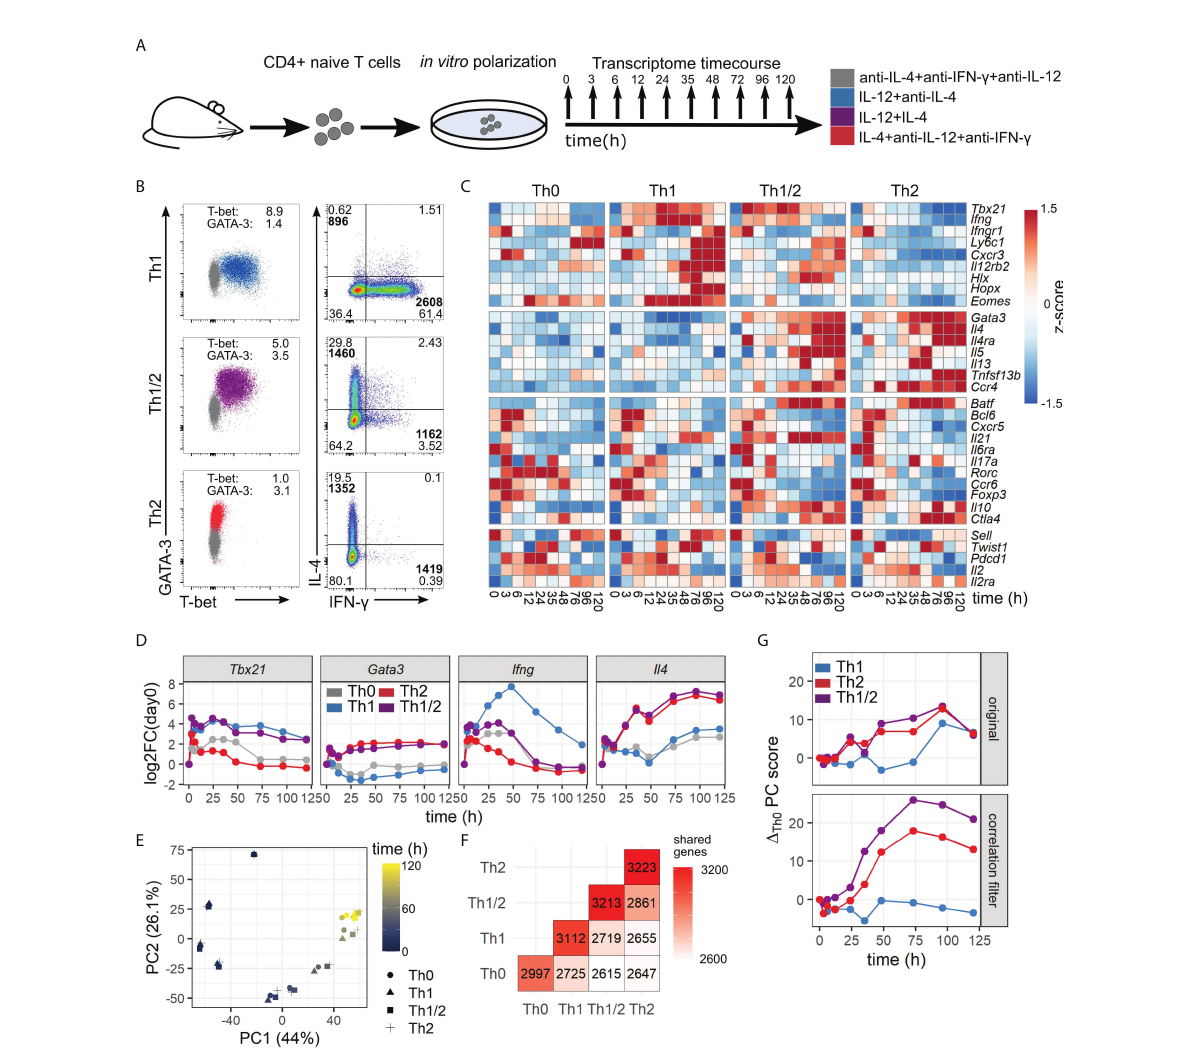
FIGURE 1 A high-resolution time course of Th-cell differentiation. (A) Experimental setup. Th-cell subsets were induced by polarizing signals in vitro , and gene expression pro fi les were obtained at 10 time points between 0 and 120 h after activation. (B) Flow-cytometric characterization of Th-cell subsets at day 5 after activation with polarizing conditions as described in (A) . Normalized geometric mean indices for T-bet and GATA-3 expression are shown. Geometric mean intensities for IFN- g - and IL-4-positive cells are indicated in bold. (C) Gene-expression pro fi les of four groups of genes (top to bottom): Th1-related, Th2-related, Tfh, and Th17-related, and other important Th cell-related genes. (D) Kinetics of master regulator transcription factors and signature cytokines for individual CD4+ T-cell subsets. Shown are normalized expression intensities as fold change relative to the fi rst measured timepoint (0 h). (E) Principal component (PC) analysis of the differentiation time course. Cell subsets are indicated by marker shape. Time of measurement is indicated by color. (F) Numbers and overlap of kinetic genes between cell subsets. (G) Evolution of PC1 over time. Shown is the difference of PC values with respect to the Th0 condition. Genes with high correlation between subsets were removed (bottom) or kept for comparison